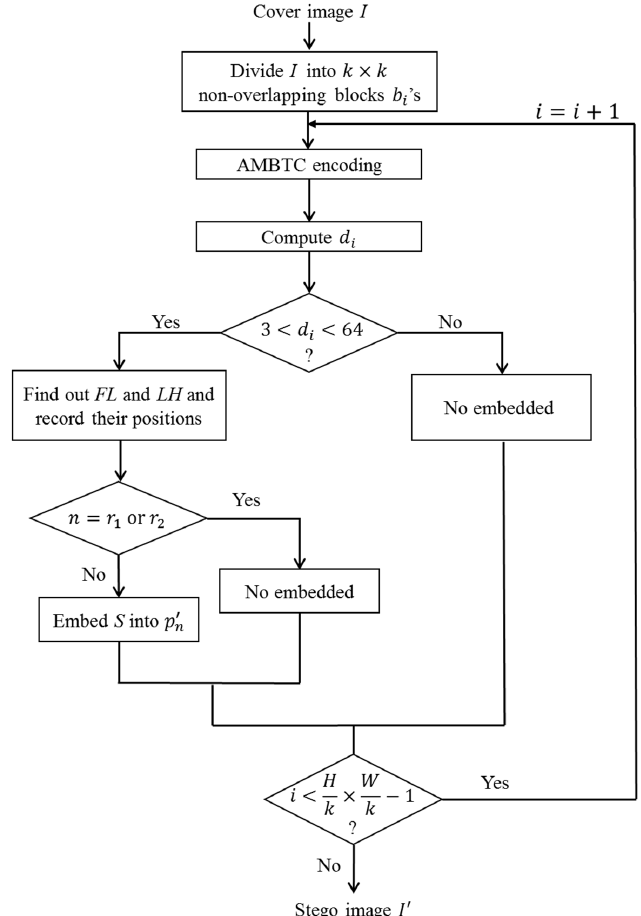
Figure 3. Flowchart of embedding phase.